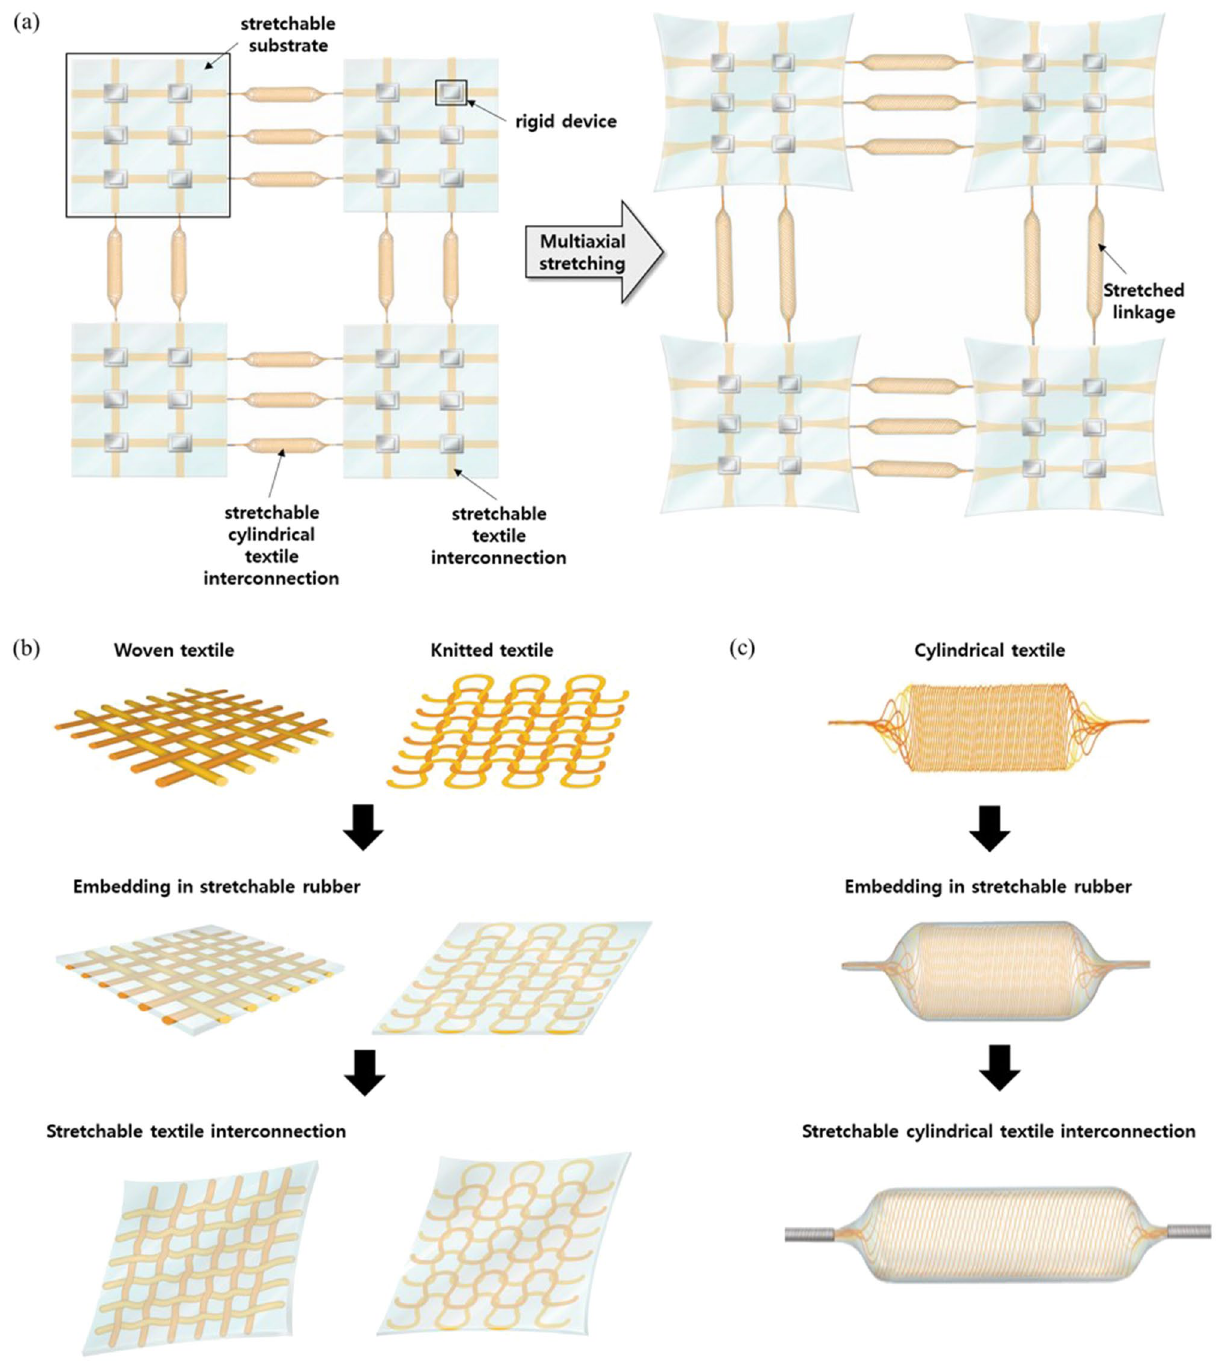
Figure 1. ( a ) Schematic image of rigid islands interconnected with stretchable textile interconnections and cylindrical interconnections, and stretched multiaxially across the entire module. Schematic image of stretchable ( b ) woven and knitted textiles ( c ) cylindrical textile encapsulated in silicone rubber and stretched textile both commercial mesh textile and wide-woven textile, show very stable electrical performance during stretching with not changing in resistance as shown in Fig. 3a,c. And for the repetitive deformation, both textile show decreasing resistance. Woven textile is created through intersection warp and weft yarns so conductivity is also transmitted in both directions. For the wide-woven textile, it shows larger resistance change than com- mercial woven mesh as shown in Fig. 3b,d. Wide-woven textile is created with large space area and smallest intersection points between warps and wefts so it is liable to change the form with less number of yarns. With some form of change under large mechanical deformation, surface temperature shows slightly unstable as well (Fig. S5). However, considering the order of resistance change, it shows stable electrical connection performance. We applied the stretchable textile as an electrical connection between silicon (Si) solar cells. Four Si solar cells